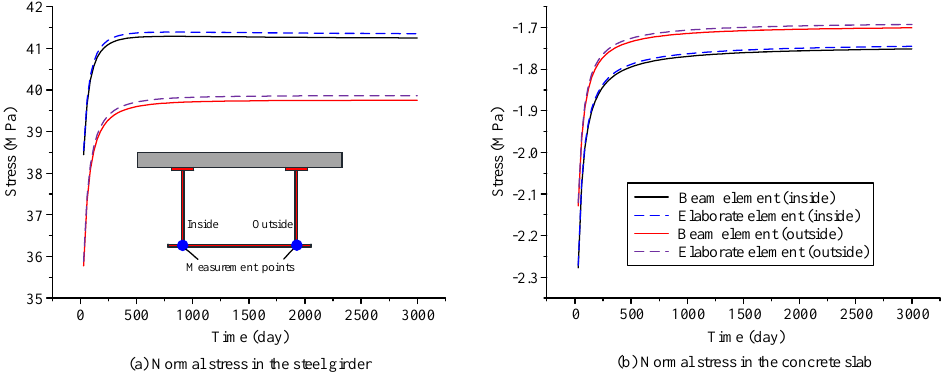
Figure 6. Stress variation in the steel girder and concrete slab of the curved composite box beam, with respect to time: ( a ) normal stress in the steel girder, ( b ) normal stress in the concrete slab.